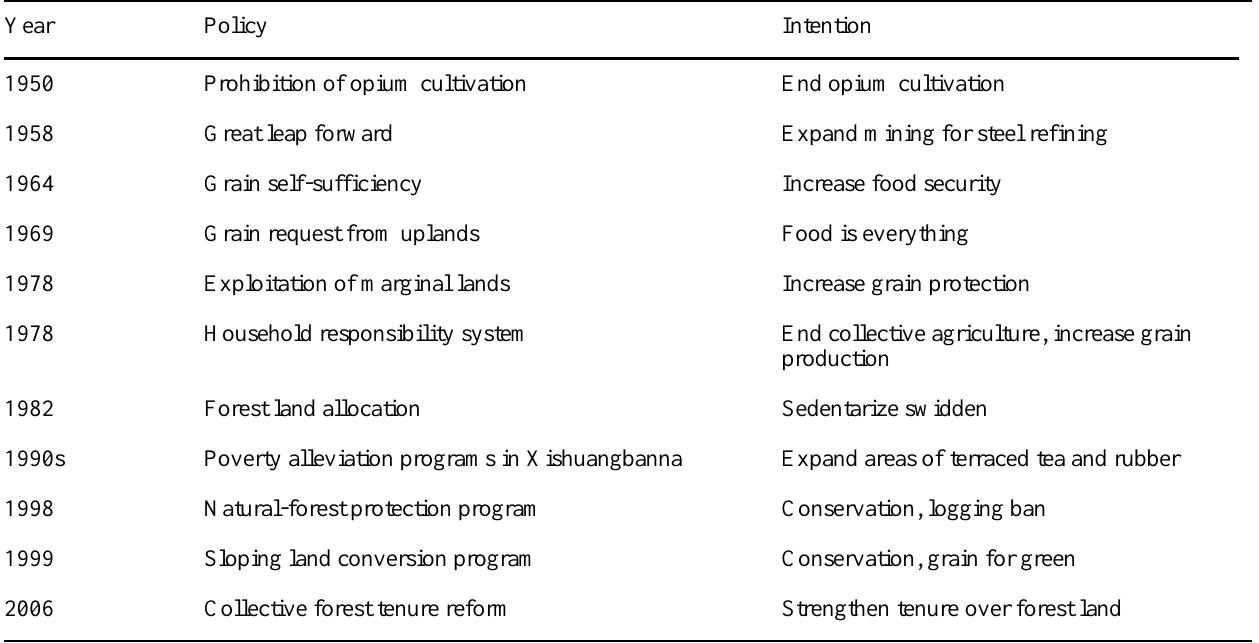
Table 1. Key policies affecting land use in